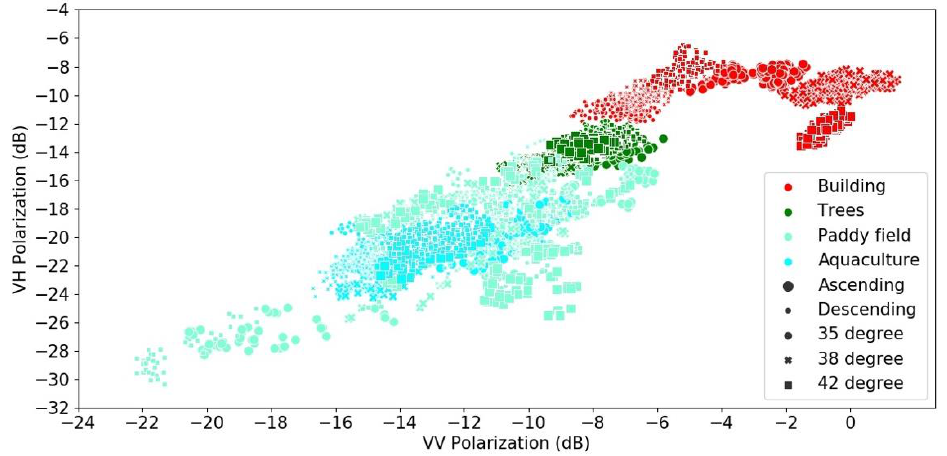
Figure 3. Multi-temporal backscatters of building structures and other land cover classes in the 2-D space for VV on the horizontal axis and VH on the vertical axis in dB.